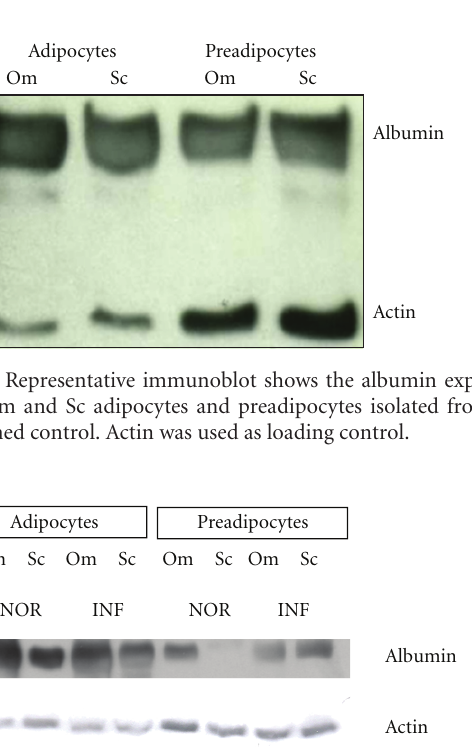
Figure 5: Representative immunoblot shows the albumin expres- sion in Om and Sc adipocytes and preadipocytes isolated from both inflamed patients (INF) and noninflamed controls (NOR). Actin was used as loading control.